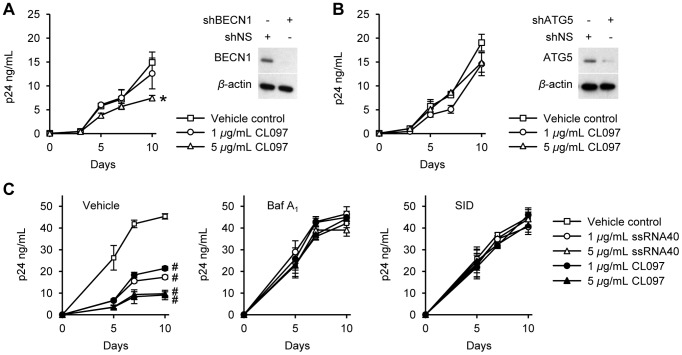
TLR8-mediated inhibition of HIV is autophagy dependent.(A–B) Macrophages transduced with BECN1 shRNA (shBECN1) (A) or ATG5 shRNA (shATG5) (B) were incubated with CL097 for 24 h before infection with HIV with continuous CL097 treatment for 10 d. Right, immunoblot analysis performed using antibodies raised to BECN1, ATG5 and β-actin. Left, ELISA performed for extracellular release of HIV p24 antigen over 10 d. Results are reported as mean ± s.e.m., n = 4. (C) Macrophages were pretreated with bafilomycin A1 (Baf A1), SID 26681509 (SID) or vehicle control before incubation with CL097 or ssRNA40 for 24 h before infection with HIV. Cells were then washed and incubated with TLR8 agonists and inhibitors for 10 d and ELISA performed for extracellular HIV p24 antigen release over 10 d. Results are reported as mean ± s.e.m., n = 5. * p<0.05; # p<0.001.